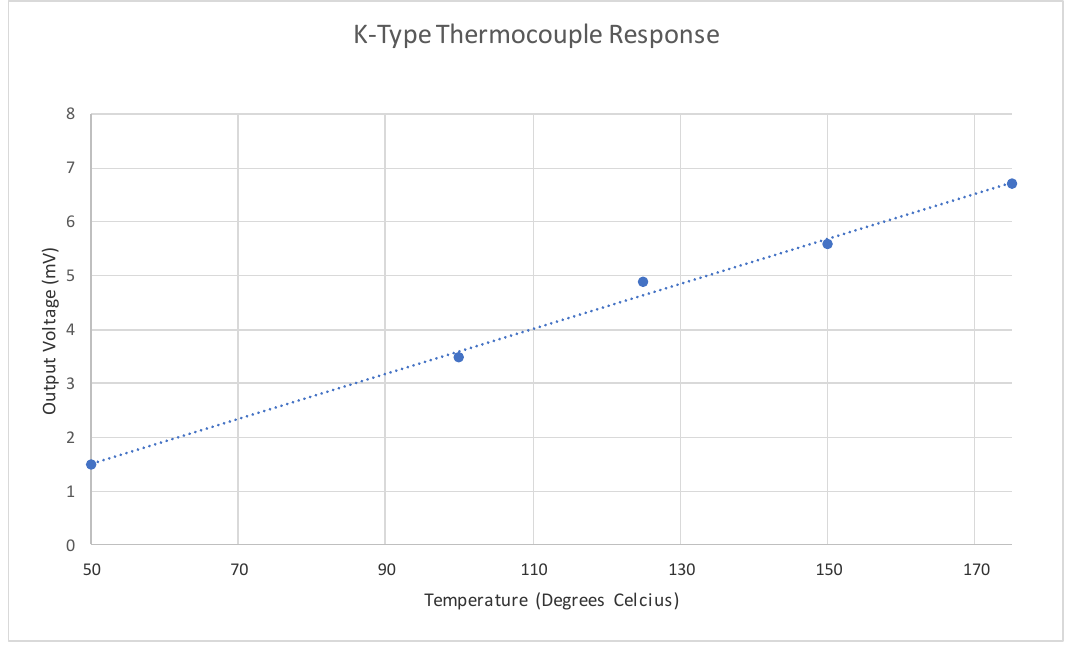
Figure 3. Thermocouple response.